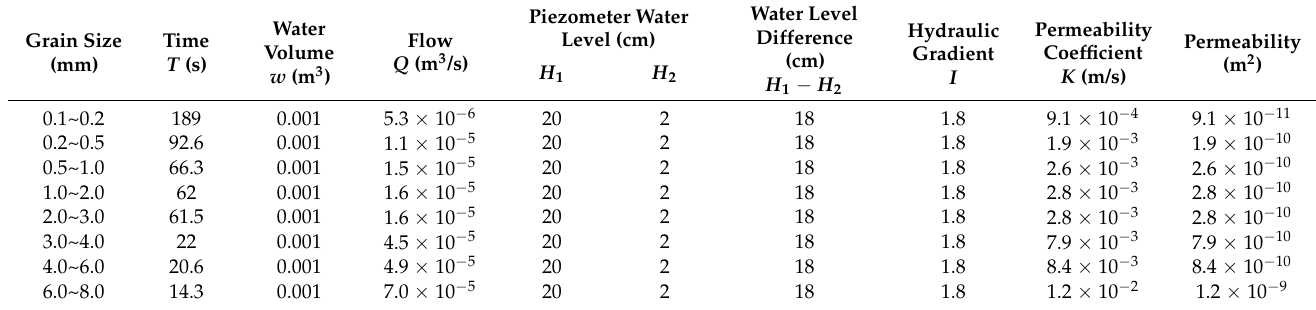
Table 2. Darcy experiment results.